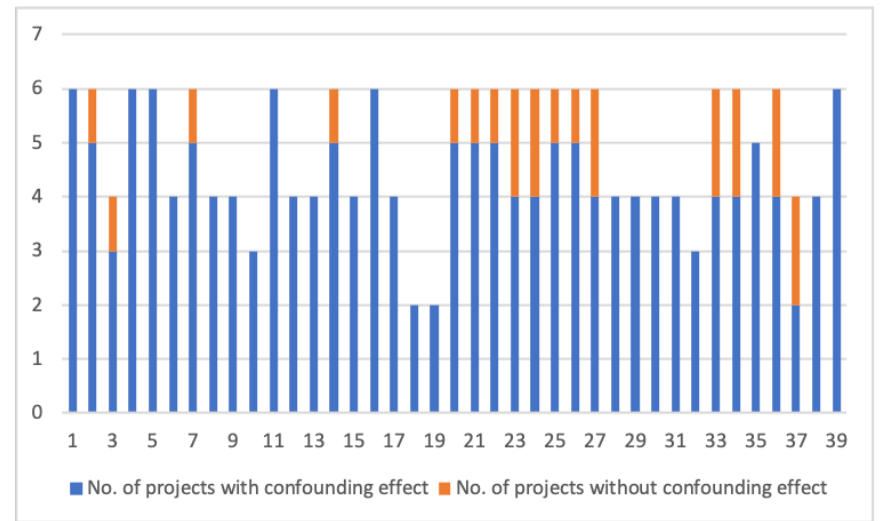
Figure 4. No. of projects for each metric with and without confounding